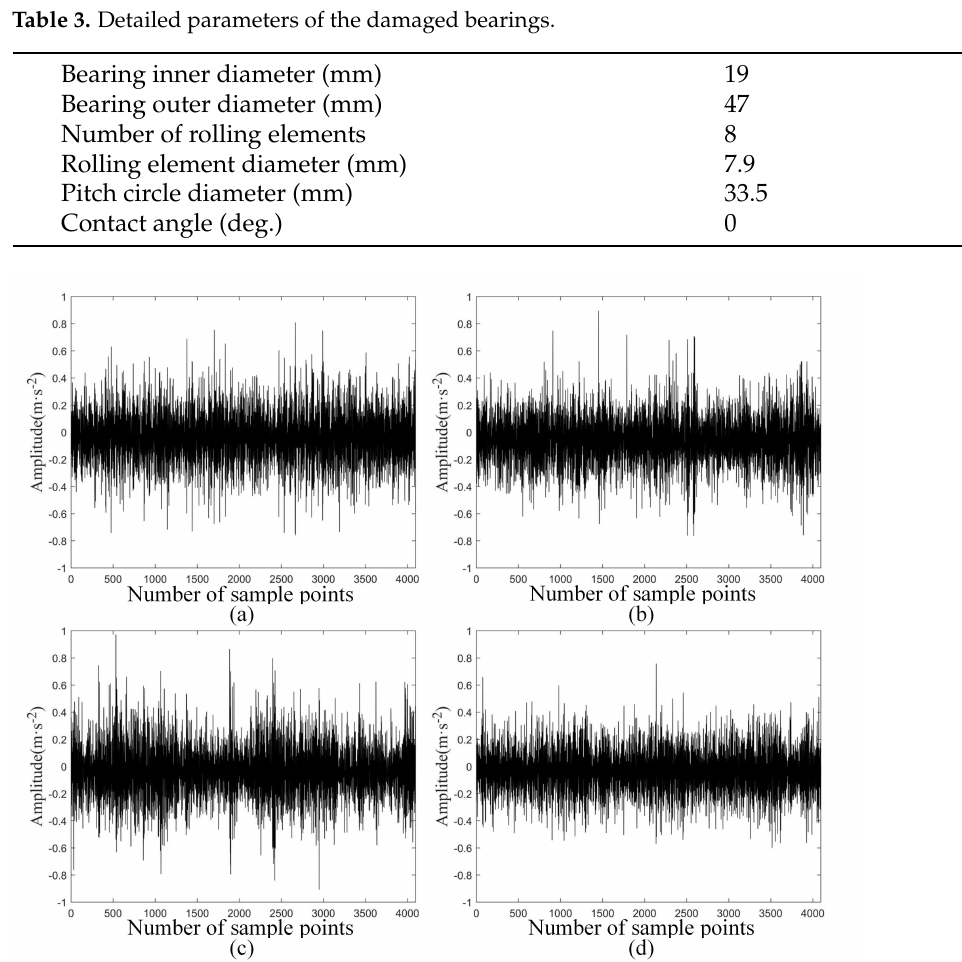
Figure 10. Time domain waveforms of ER–12K rolling bearings in four states: ( a ) Inner race fault, ( b ) Outer race fault, ( c ) Rolling element fault, ( d ) Normal